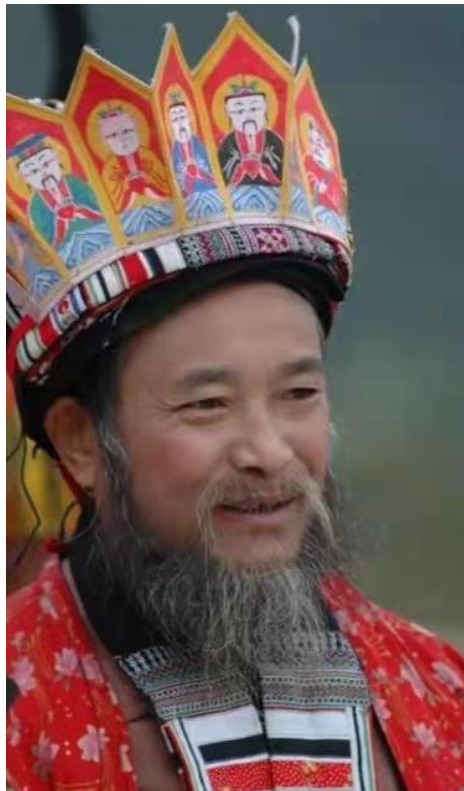
Figure 1. Master Zhao Youfu in religious gown and crest (provided by Master Zhao himself).